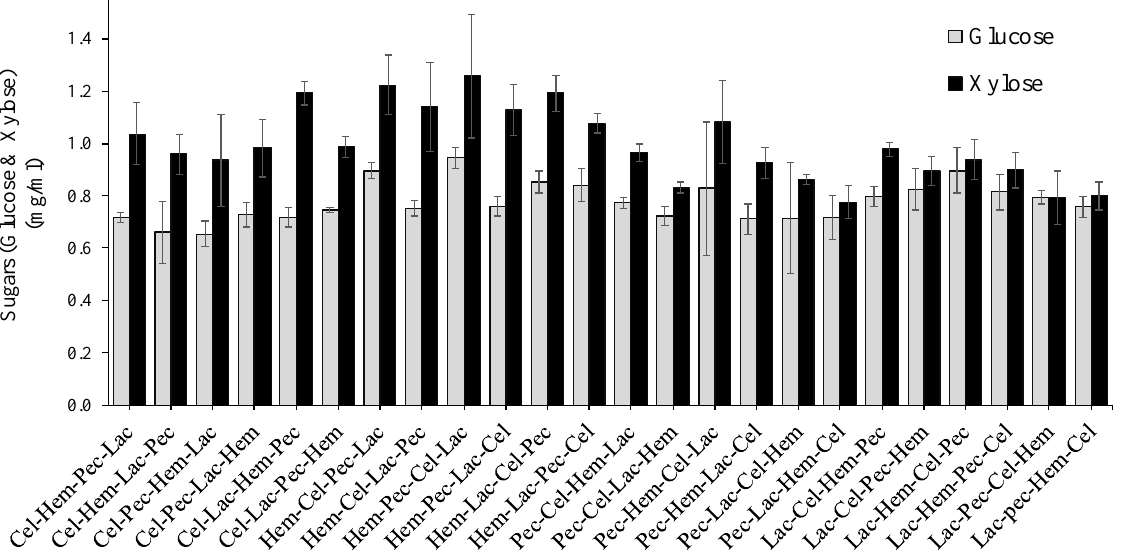
Figure 3. Comparison between total glucose and xylose produced during four steps enzyme digestion for the corn stover. The error bars represent standard error of the mean ( n = 3).